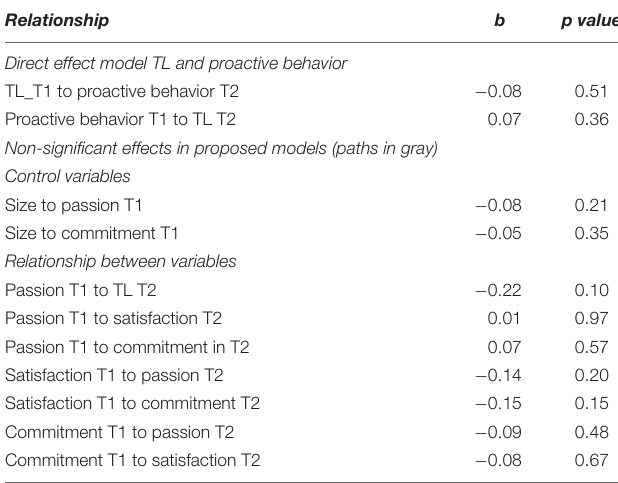
TABLE 4 | Direct effects and eliminated